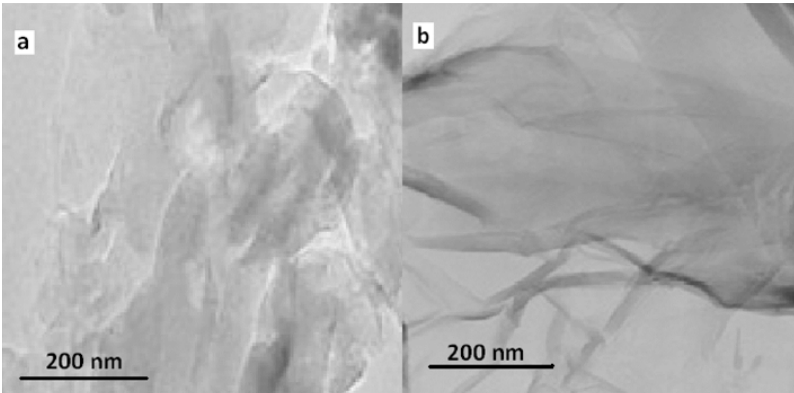
Fig. 5. TEM images of the g-C